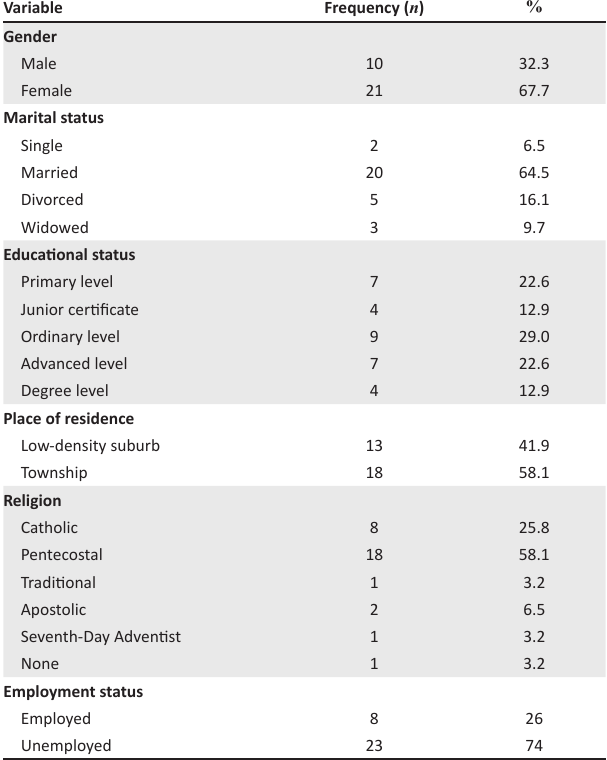
FIGURE 1: Relationship of caregiver to the TABLE 1: Socio-demographic characteristics of the respondents.